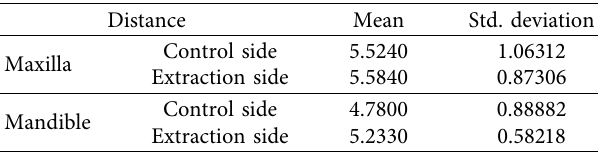
Table 4: Distribution between the extraction and nonextraction